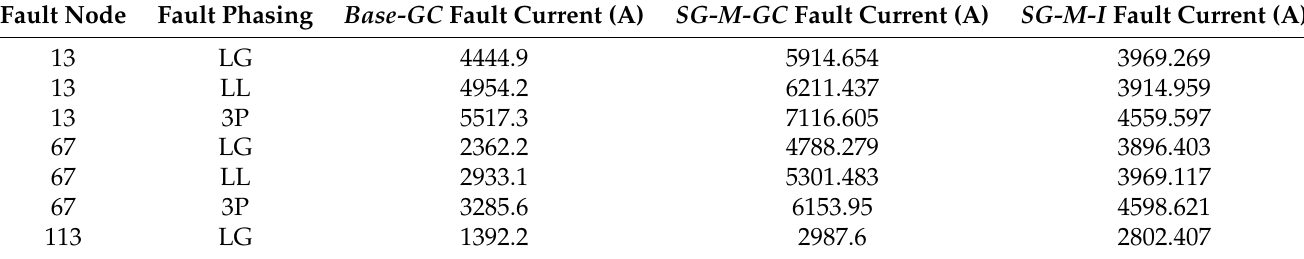
Table 6. Comparison of results for configurations Base-GC, SG-M-GC and SG-M-I of the IEEE 123-Node System. Fault Node Fault